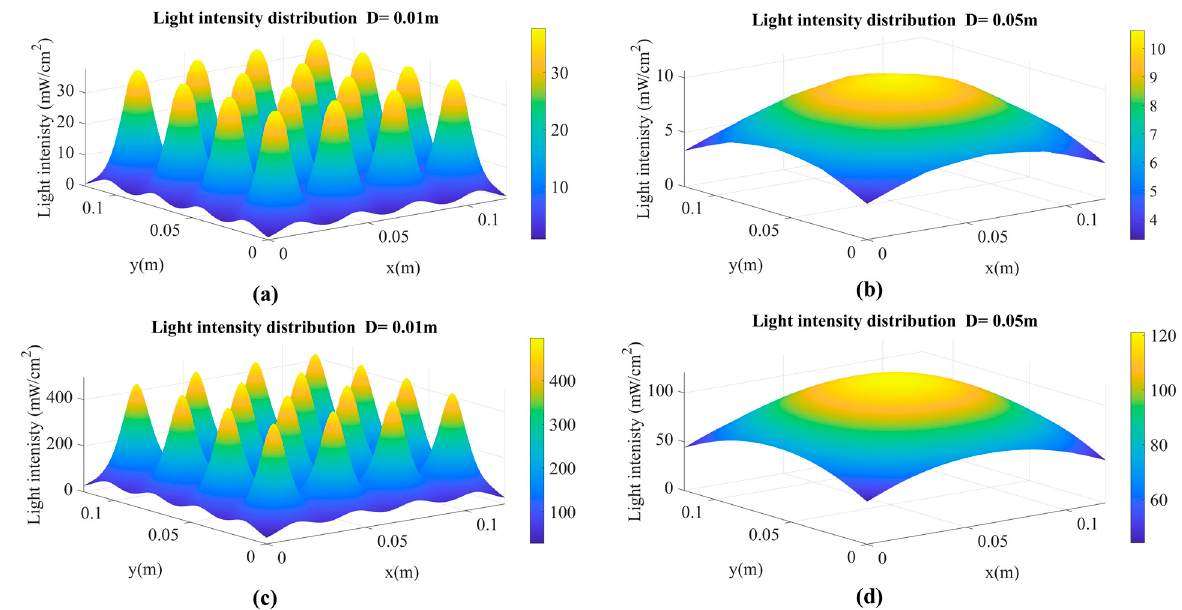
Figure 4. Light intensity distribution for the 280 nm LED reactor and 405 nm LED reactor (input current = 500 mA): ( a ) 280 nm LED reactor, D = 0.01 m; ( b ) 280 nm LED reactor, D = 0.05 m; ( c ) 405 nm LED reactor, D = 0.01 m; ( d ) 405 nm LED reactor, D = 0.05 m. Table 2. Statistics of light intensity (mW/cm 2 ), as received by the Petri dish.